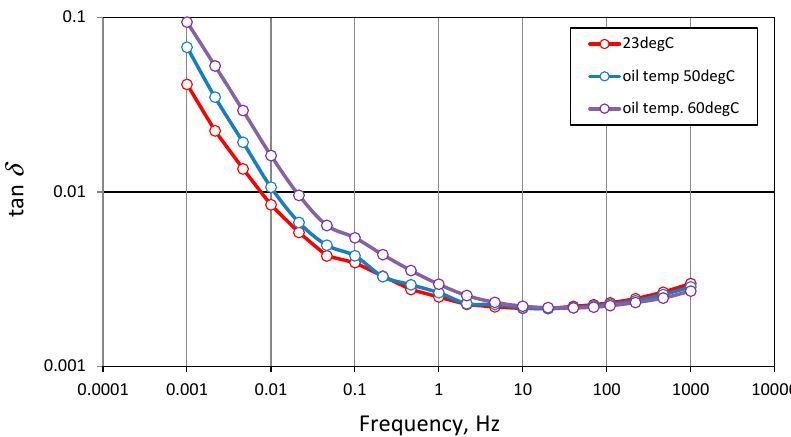
Figure 7. Dielectric response of the bushing insulation with non-uniform temperature distribution; measurements made at an ambient temperature of 23 °C; temperature of the oil part at 50 °C and 60 °C.